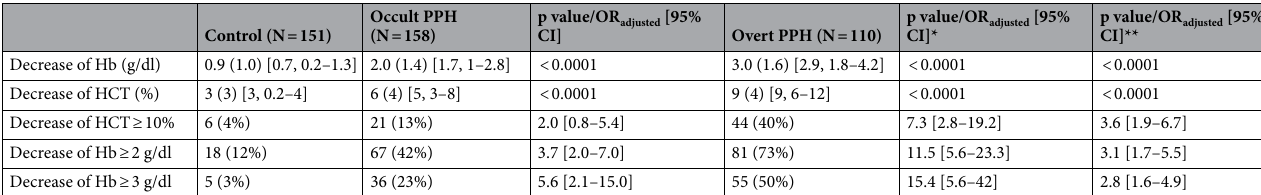
Table 3. Decrease in hemoglobin and hematocrit during the immediate postpartum period. Values are presented as mean (SD) [median, Interquartile range] or number (percent). * Comparison between “Overt PPH” and “Control”. ** Comparison between “Overt PPH” and “Occult PPH”. OR was adjusted for primiparity, epidural, perineal tears, episiotomy, Hb before delivery, HCT before delivery, delivery number and delivery week. Hb hemoglobin, HCT hematocrit, OR odds ratio.